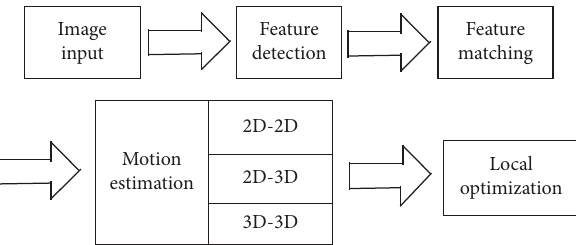
Figure 9: Te direct method.